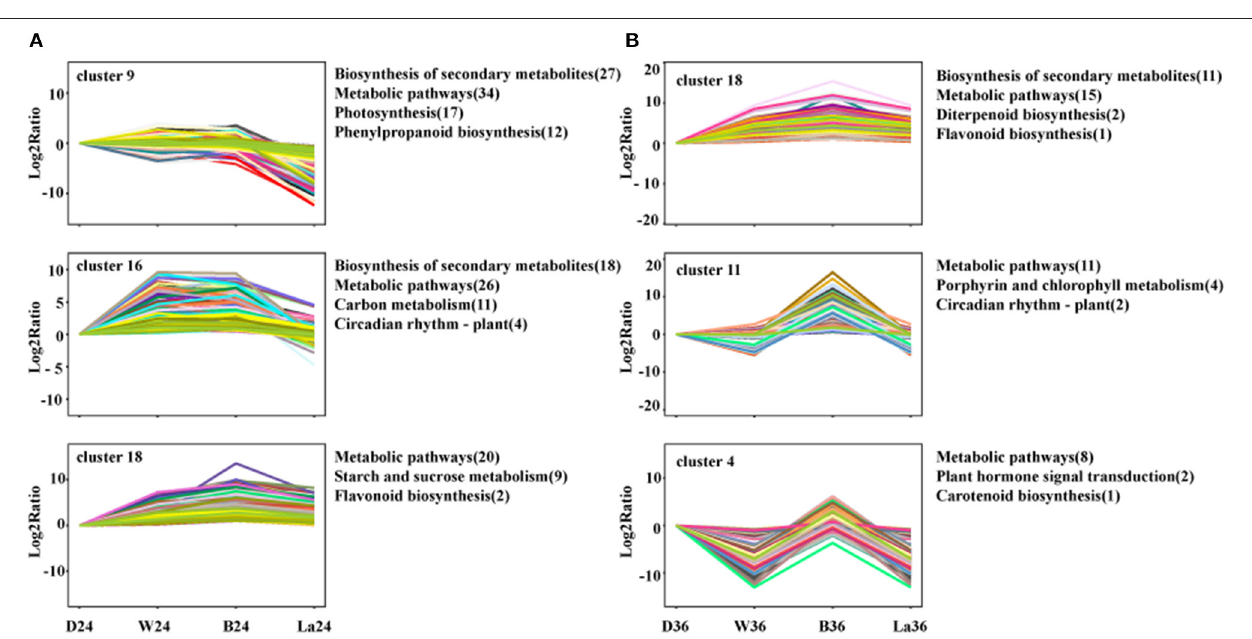
FIGURE 7 | Cluster analysis of DEGs with significant expression profile changes and KEGG pathway enrichment analysis at 24h (A) and 36h (B) . All the DEGs were subjected to complete-linkage hierarchical clustering using a Euclidean distance metric and divided into 20 clusters at two time points. Enriched KEGG pathways are listed to the right of each cluster. D: dark. W: white light. B: blue light. La: blue light + 1mM LaCl 3 , 24 or 36h.